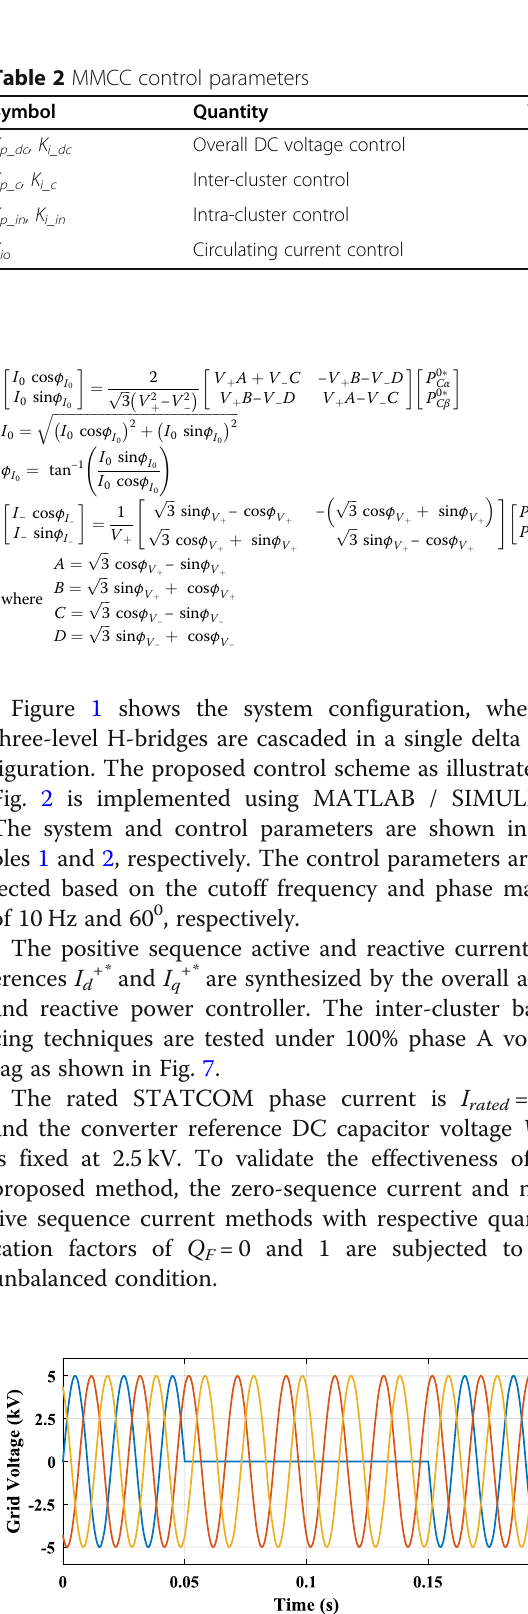
Fig. 7 Grid voltage waveform under 100% phase A voltage sag during 100 ms ( V ao , V bo , V co